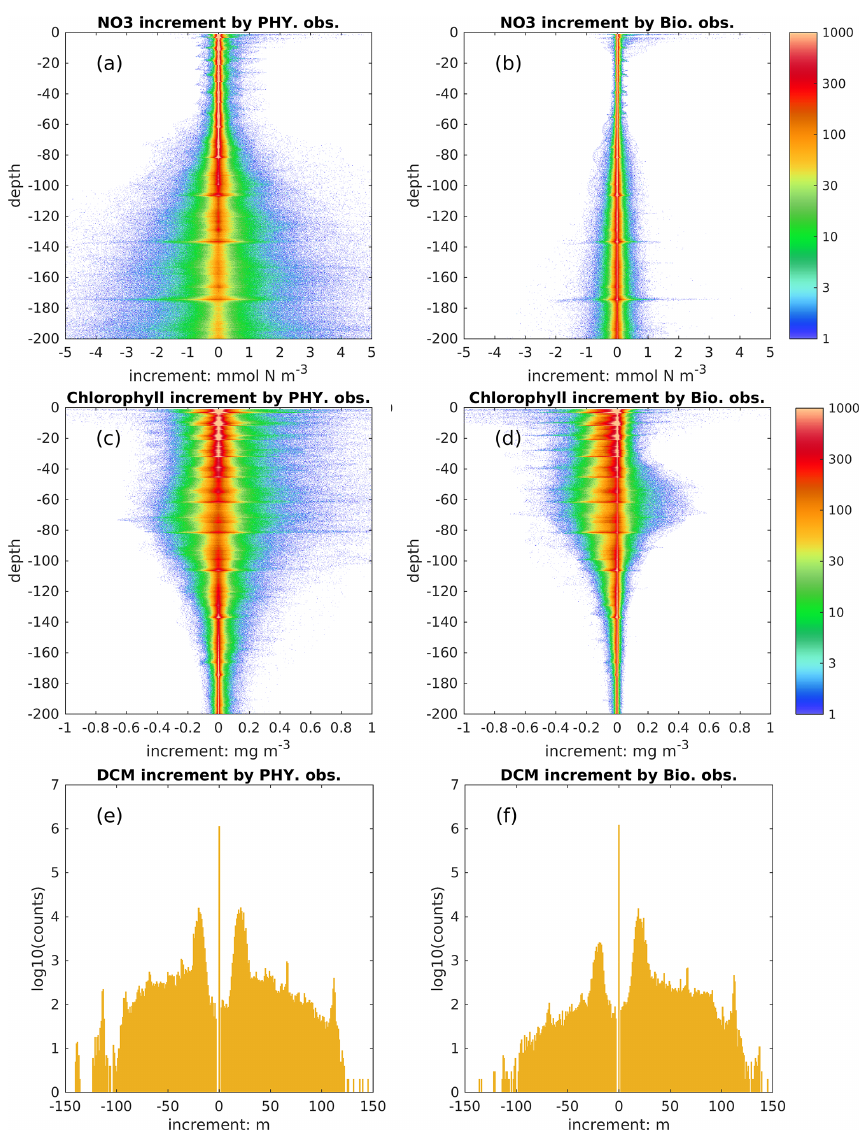
Figure 10. Histogram of increments in nitrate (mmolNm − 3 ), chlorophyll (mgm − 3 ), and DCM depth (m) obtained by assimilating physical and biological